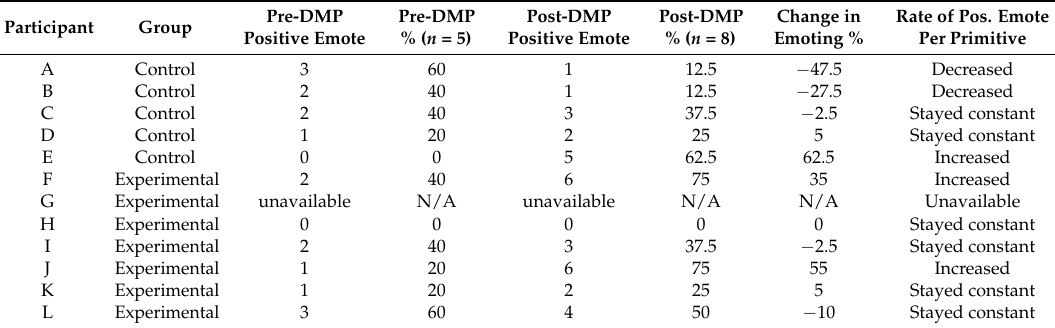
Table A3. Change in participant’s emoting behavior towards OP2 before and after